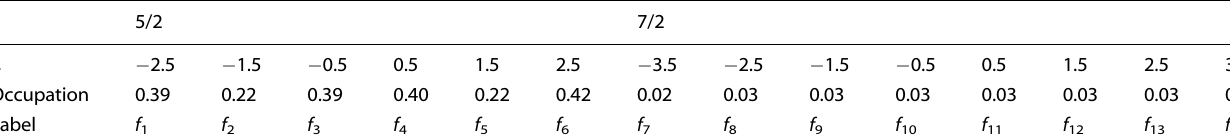
Table 1. Calculated electron occupation of U-5 f orbitals in UTe 2 at T = 300 K. U-5 f orbitals are labelled for convenience in this